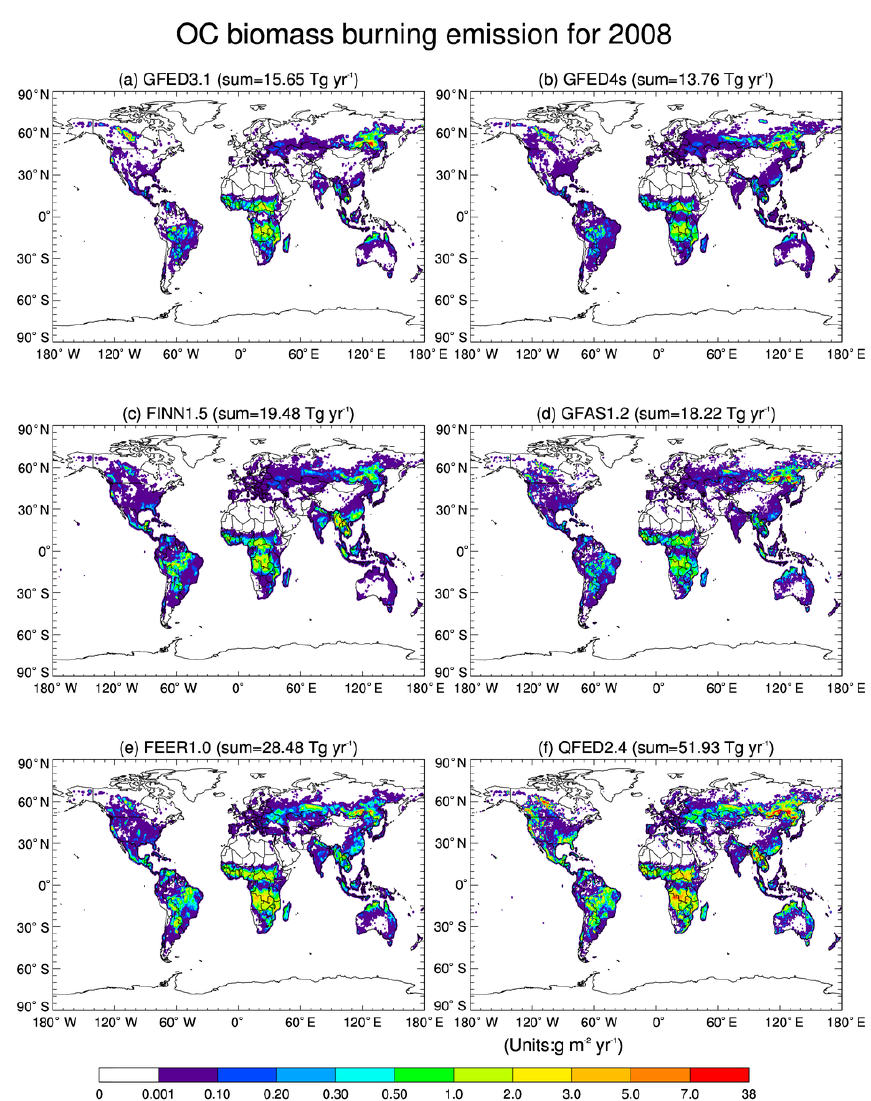
Figure 2. The spatial distribution of annual total organic carbon (OC) biomass burning emissions for 2008 estimated by six biomass burning emission datasets (units: gm − 2 yr − 1 ). The global annual total amount for each dataset in 2008 is indicated in the